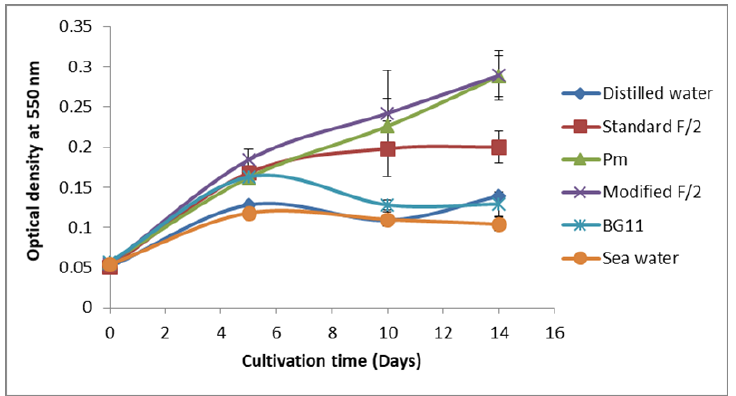
Figure 1. Screening of the most suitable culture media for Rhodomonas sp. growth. (Data are means ± SE).